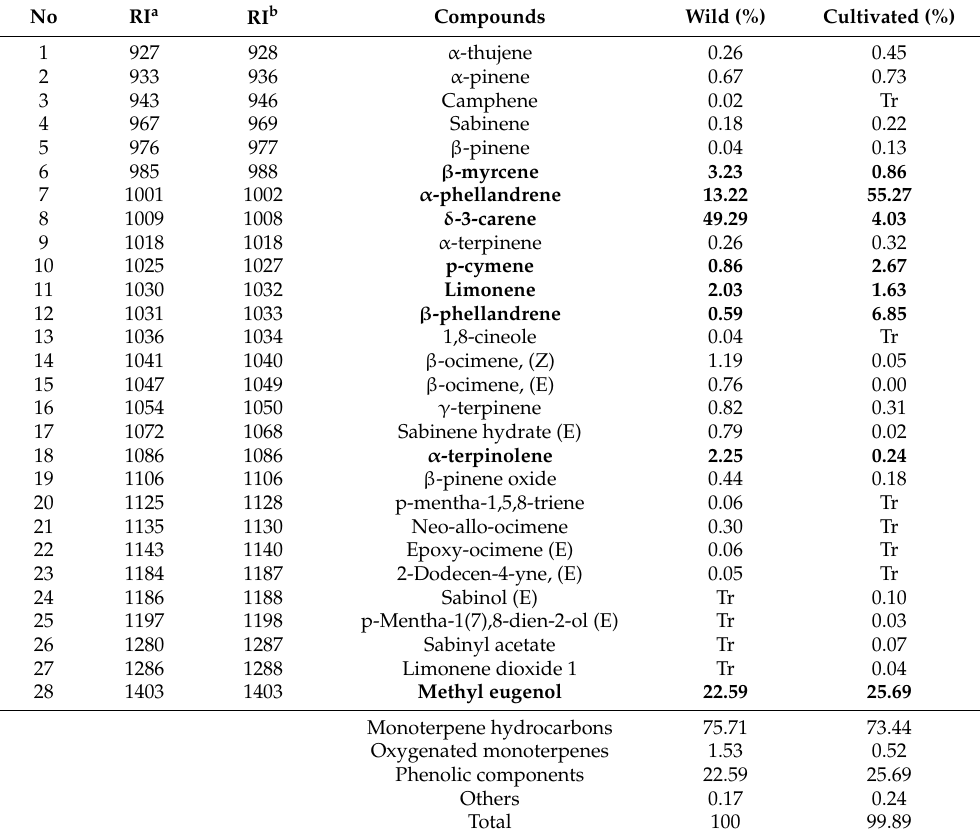
Table 2. Chemical composition of the essential oils of wild and cultivated E. tenuifolia subsp. sibthorpi- ana